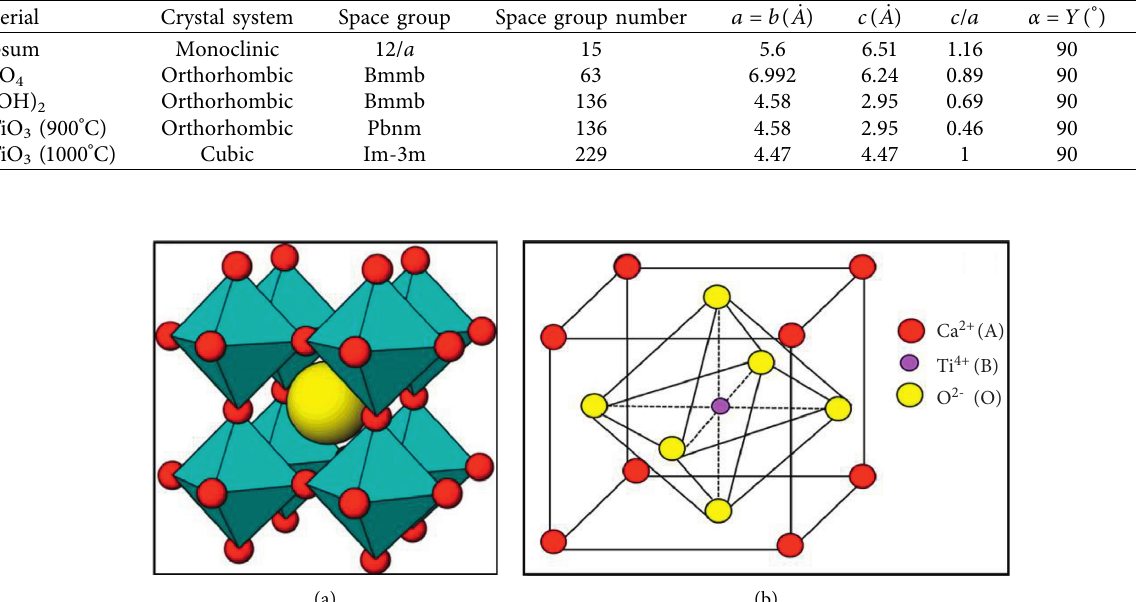
Figure 5: (a) Ideal cubic perovskite structure for ABO3 (cyan, BO6 units; yellow, A atoms) (Reprinted with permission from reference [18]-[11] copyright from Elsevier). (b) Illustration of the crystal structure of CaTiO 3